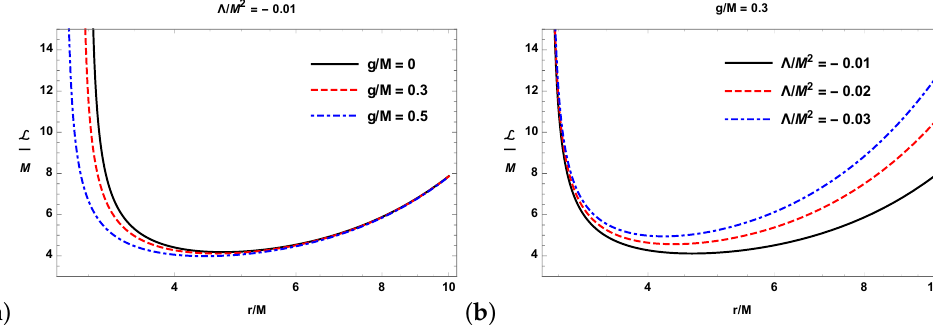
Figure 5. The dependence of the angular momentum of a particle on circular orbit radius static regular Bardeen black hole in Anti-de Sitter spacetime. ( a ) for the fixed Λ and ( b ) for the fixed g